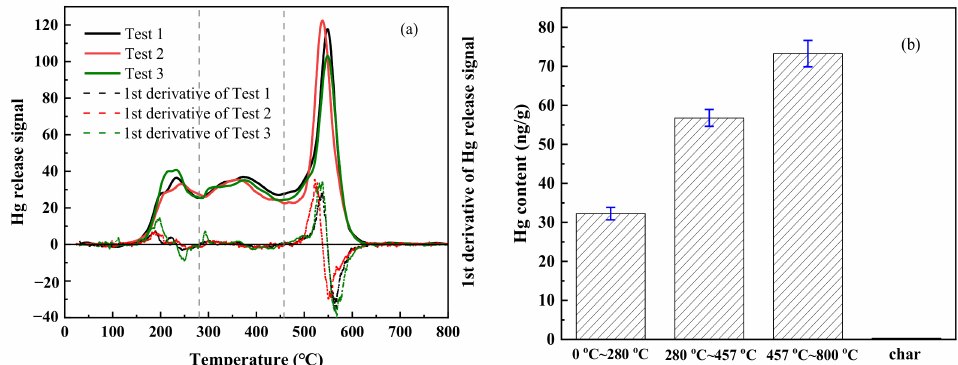
Figure 4. Replicability of three parallel tests for Hg thermal release from the B3 sample. ( a ) Replicability of three parallel